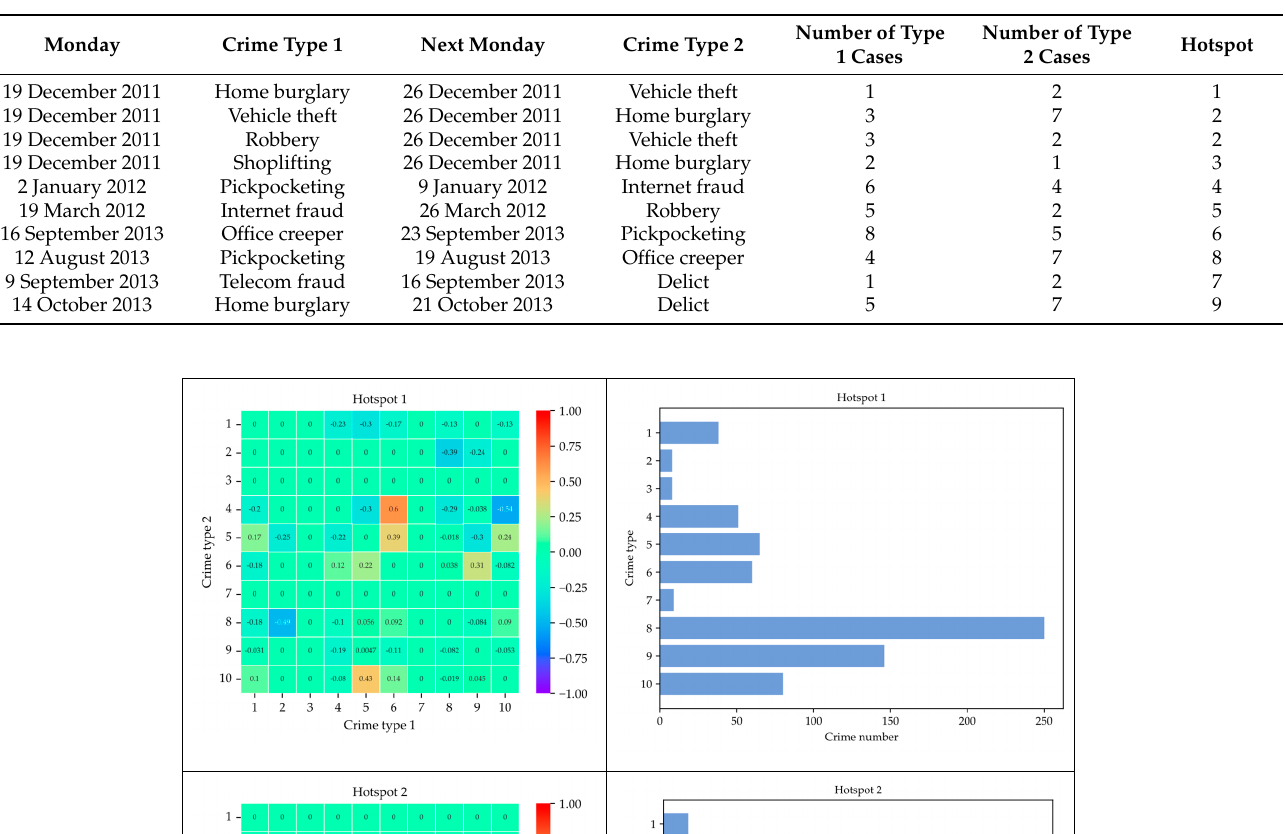
Table 3. Crime type correlations.